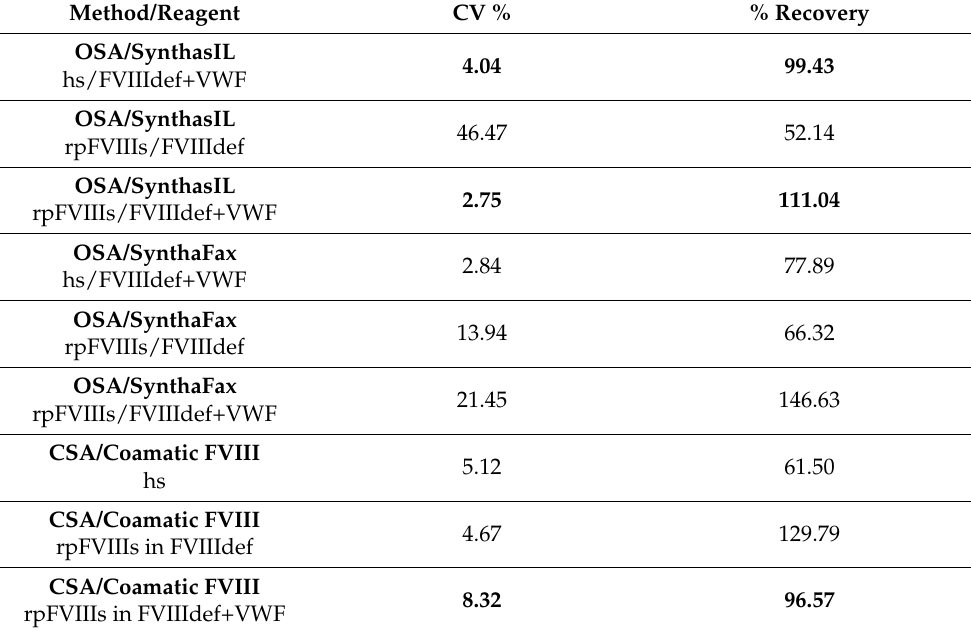
Table 3. Inter-laboratory